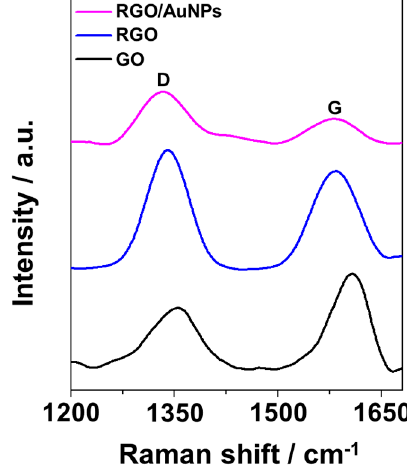
Figure 3. Raman spectra of GO, RGO, and RGO/AuNPs nanocomposites.